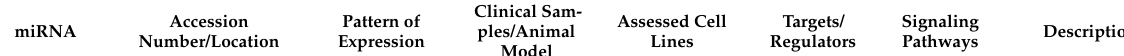
Table 2. miRNAs and pituitary gland tumors (ANTs: adjacent non-tumor samples).